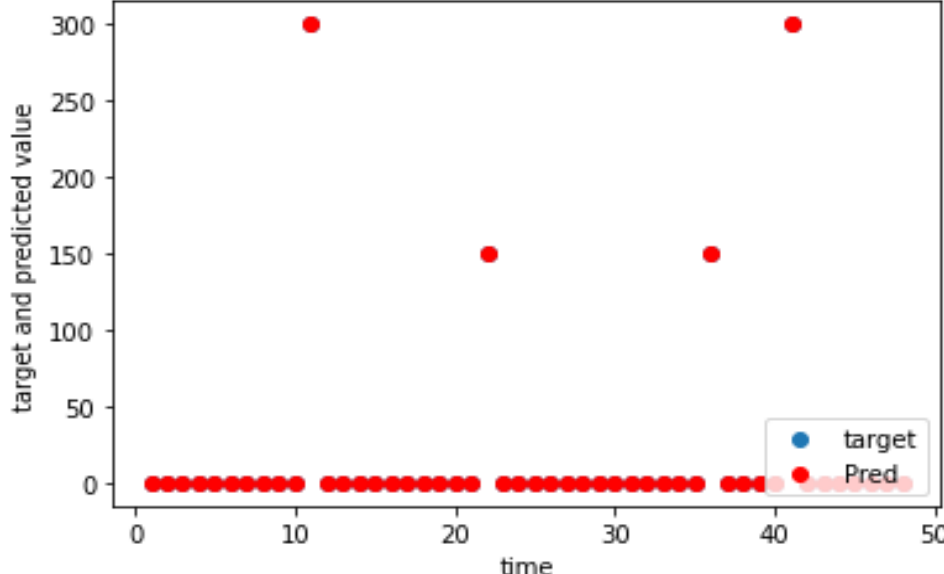
Figure 7. Charging demand prediction of a weekday for Teekkarikylä.